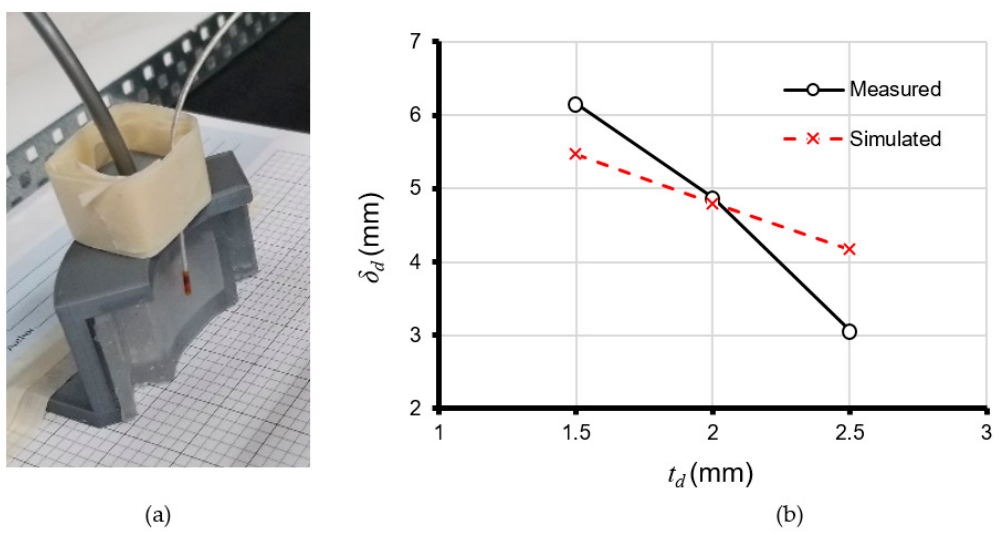
Figure 8. ( a ) Experimental setup for measuring actuator displacement. ( b ) Measured and simulated displacements δ d for three expandable wall thicknesses t d .